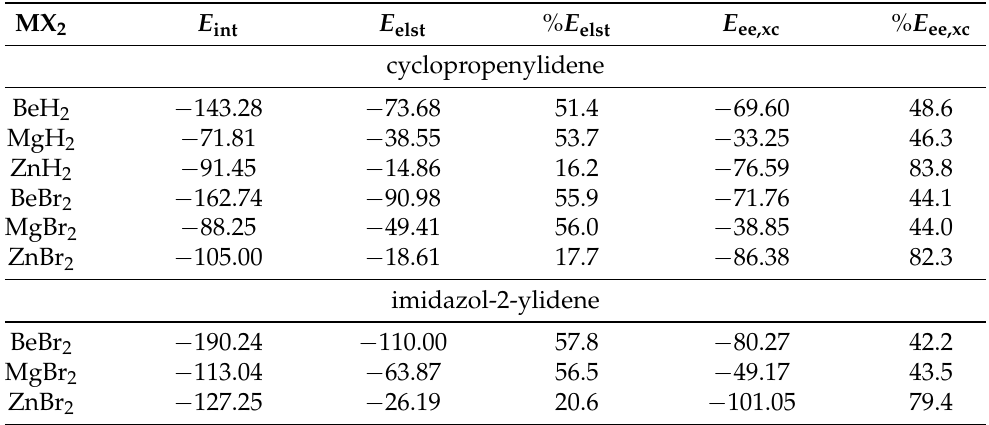
Table 3. Sums of the IQA-based energy terms (in kcal/mol) computed (MP2/6-311+G(d,p)) for groups of atoms reflecting the ETS-NOCV fragmentation, that is {carbene} · · · {MX 2 } . MX 2 E int E elst % E elst E ee,xc % E ee,xc cyclopropenylidene BeH 2 MgH 2